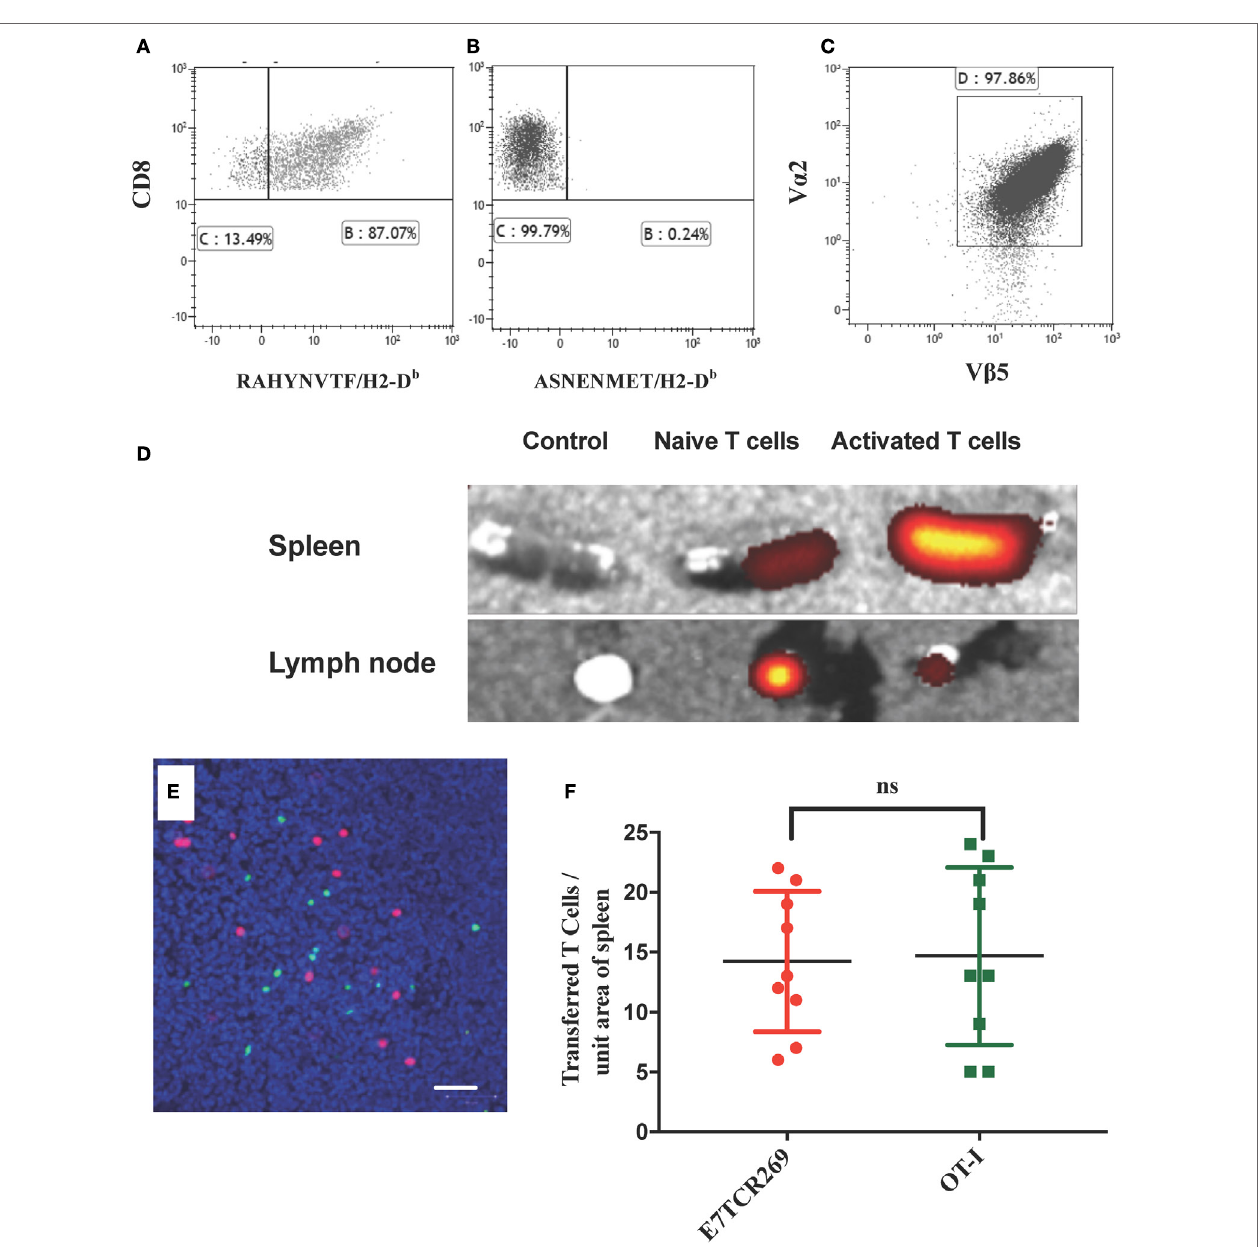
FigUre 2 | Migration of naïve and activated antigen-specific T cells to lymphoid organs . (a,B) Splenocytes from B6.E7TCR269 mice, transgenic for the β chain of an E7-specific T cell line, were stimulated in vitro for 2 weeks with an H2-D b -restricted peptide of E7 (RAHYNIVTF) and stained with a fluorescently labeled peptide/MHC dextramer consisting of (a) RAHYNIVTF/H2-D b complexes or (B) ASNENMET/H2-D b complexes. (c) Splenocytes from B6.OT-I mice, transgenic for a TCR specific for the ovalbumin peptide SIINFEKL, were stimulated in vitro for 2 weeks with SIINFEKL peptide. CD8 T cell expression of TCR V α 2 and V β 5 is shown. Flow cytometry plots gated on live, singlet cells. (D) Spleen and inguinal lymph nodes were harvested from C57BL/6 mice 24 h after i.v. injection of 2.5 × 10 6 fluorescently labeled (eFluor 670) CD8 T cells from B6.E7TCR269 mice, either naïve or exposed in vitro to E7 peptide as in (c) . Imaging of harvested organs by IVIS Spectrum Preclinical Imaging System. Control tissue was obtained from mice injected with PBS. (e) Equal numbers (2.5 × 10 6 cells per mouse) of in vitro -activated E7TCR269 T cells labeled with eFluor 670 (green) and in vitro -activated OT-I CD8 T cells labeled with CytoPainter orange fluorescence (red) were injected intravenously into C57BL/6 mice. After 24 h, 10 µm frozen sections of spleen were prepared, counterstained with Hoechst 33342, and imaged by confocal Zeiss microscopy. Scale bar represents 50 µm. (F) Quantitation of cells from (e) over nine high power fields (ns = not